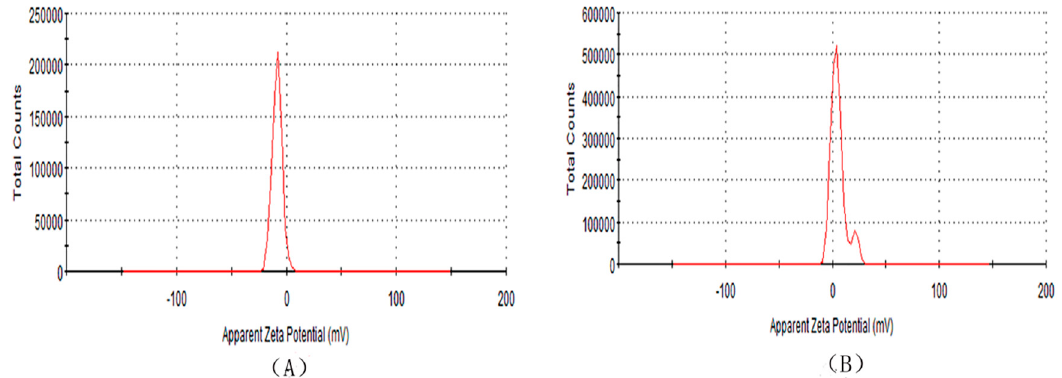
Figure 3. Zeta potential of ( a ) PLGA microparticles and ( b ) chitosan–PLGA microparticles.